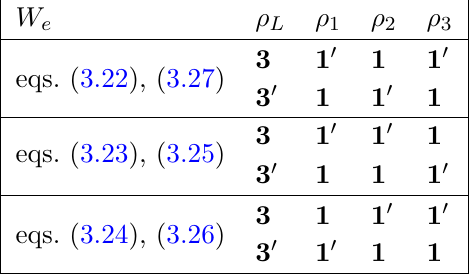
, E c and E c super(cid:12)elds in the described 1 2 3